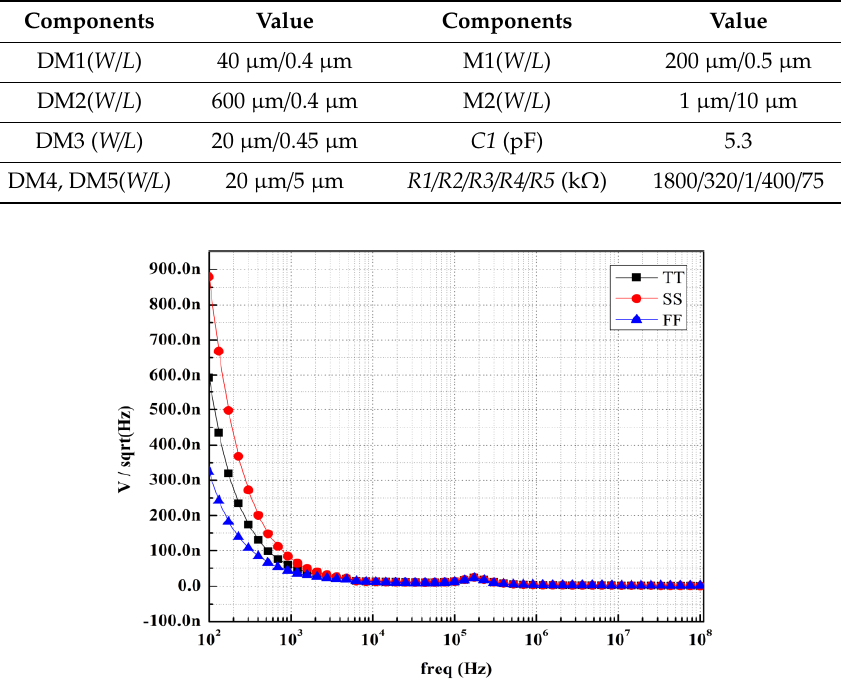
Figure 3. Simulated noise of Vref 1 versus increasing frequency.